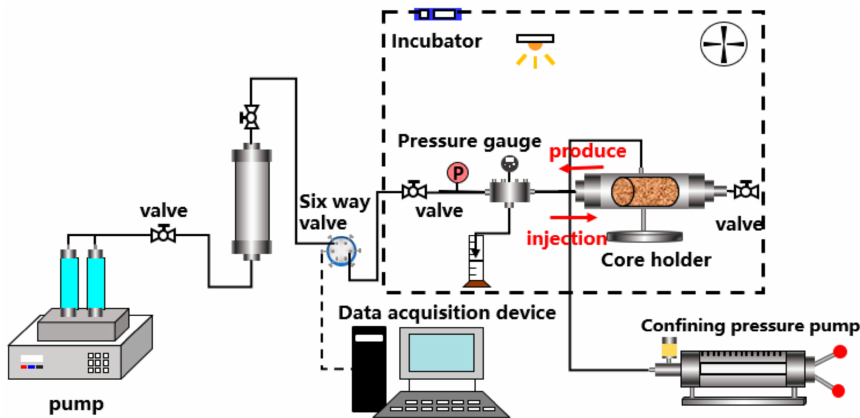
Figure 2. Schematic diagram of multiwheel injection and mining